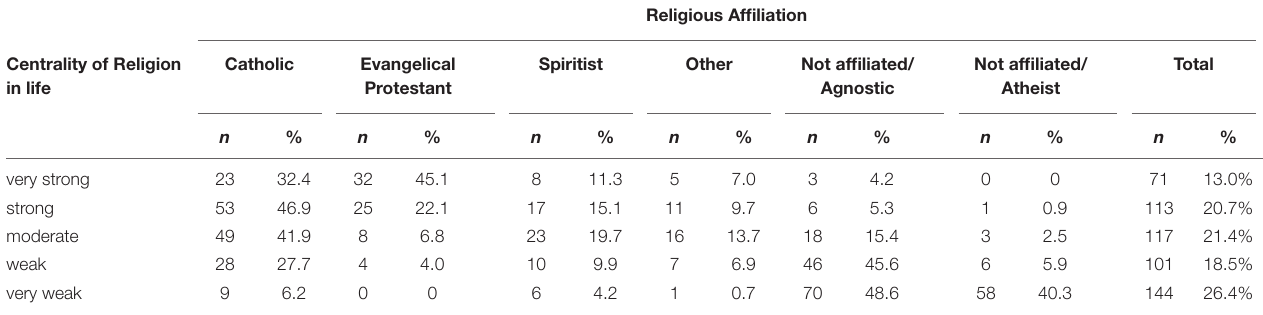
TABLE 7 | Centrality of religion in the lives of students from different religious affiliations.